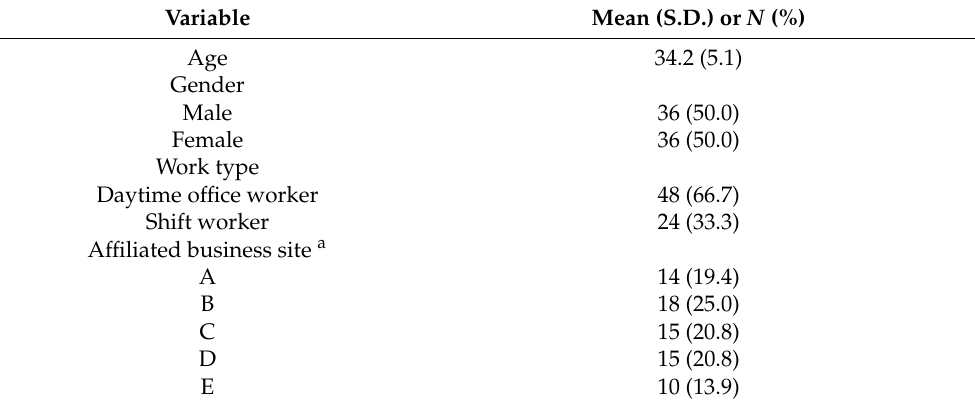
Table 2. Background information of participants.